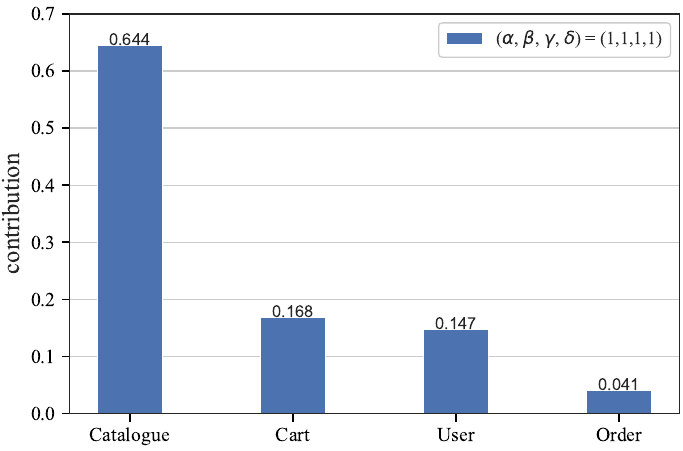
Figure 8. The database contributions to business scenarios in Sock-Shop .